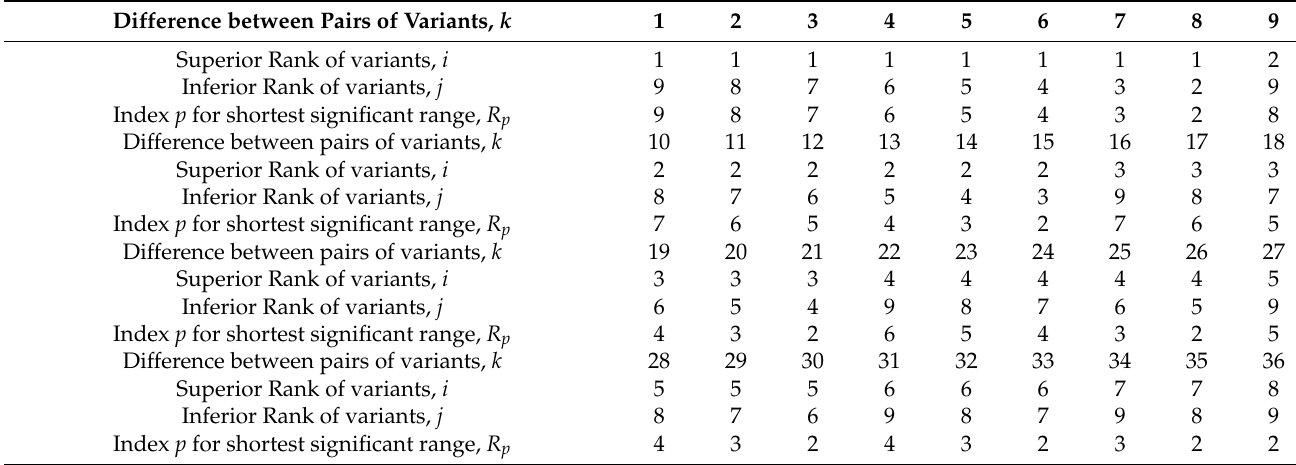
Table 5. The values for the ranks of variants, i and j , as well as for the index p . Difference between Pairs of Variants,